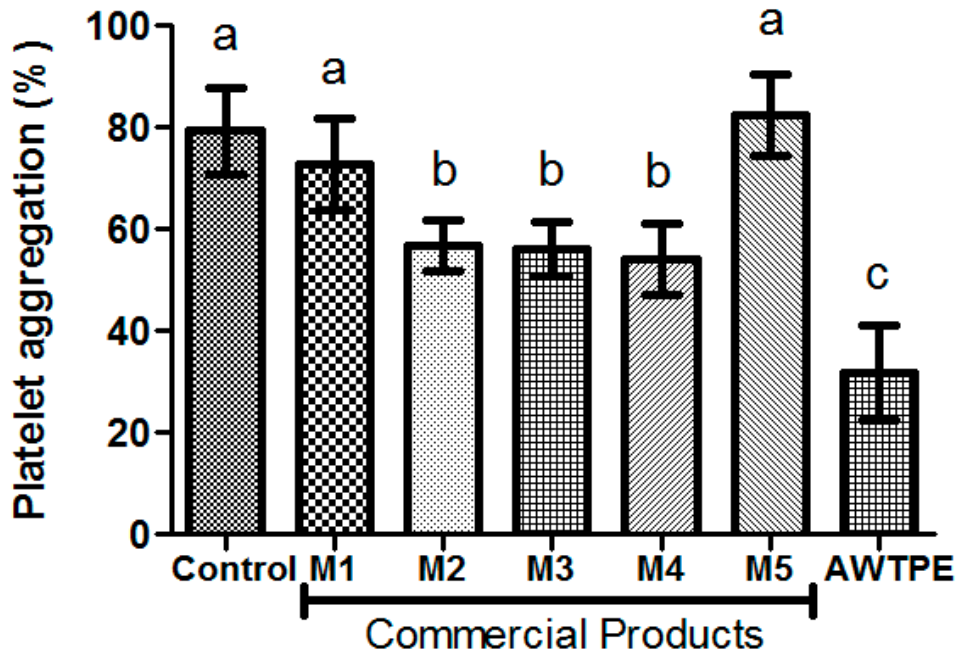
Figure 1. Platelet anti-aggregant activity of commercial products. Different letters indicate a significant difference with a p value < 0.05. AWTPE: aqueous whole tomato pomace extract cycle 3;